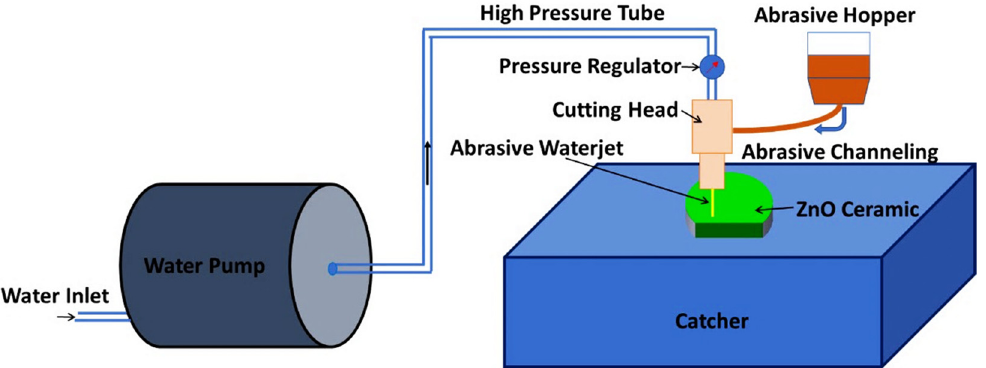
Figure 4. Schematic illustration of waterjet machining setup.